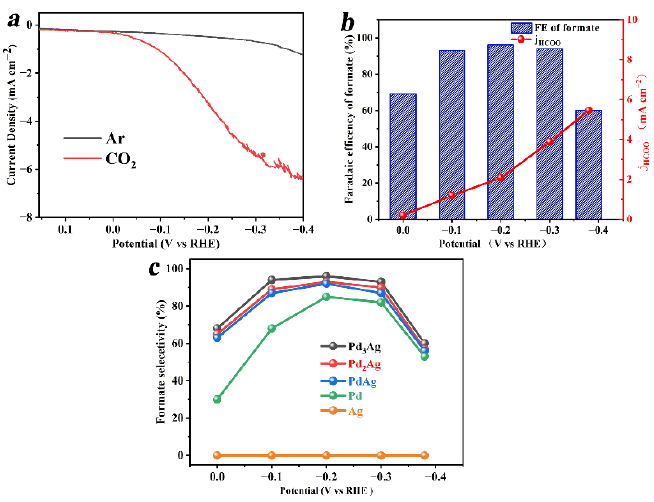
Figure 3. Electrochemical measurements of Pd 3 Ag: ( a ) polarization curves in Ar or CO 2 saturated 0.1 M KHCO 3 ; ( b ) potential-dependent FE for formic acid and partial current density; ( c ) selectivity for formic acid on Ag, Pd, PdAg, Pd 2 Ag, and Pd 3 Ag. The text continues here.